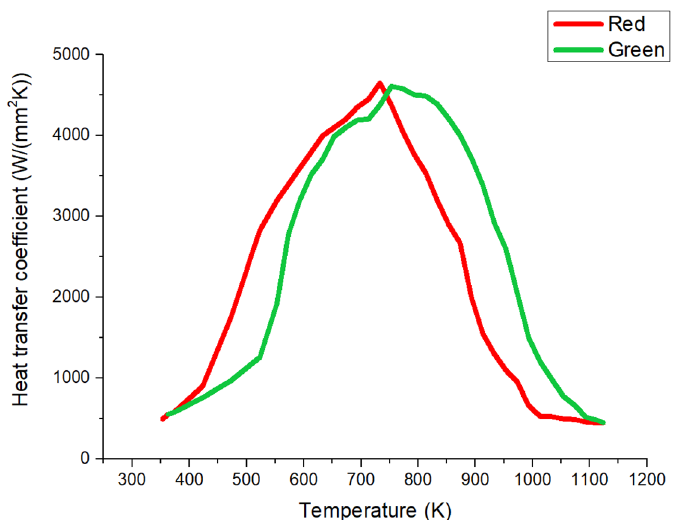
Figure 7. Heat transfer coefficients used in numerical simulation.